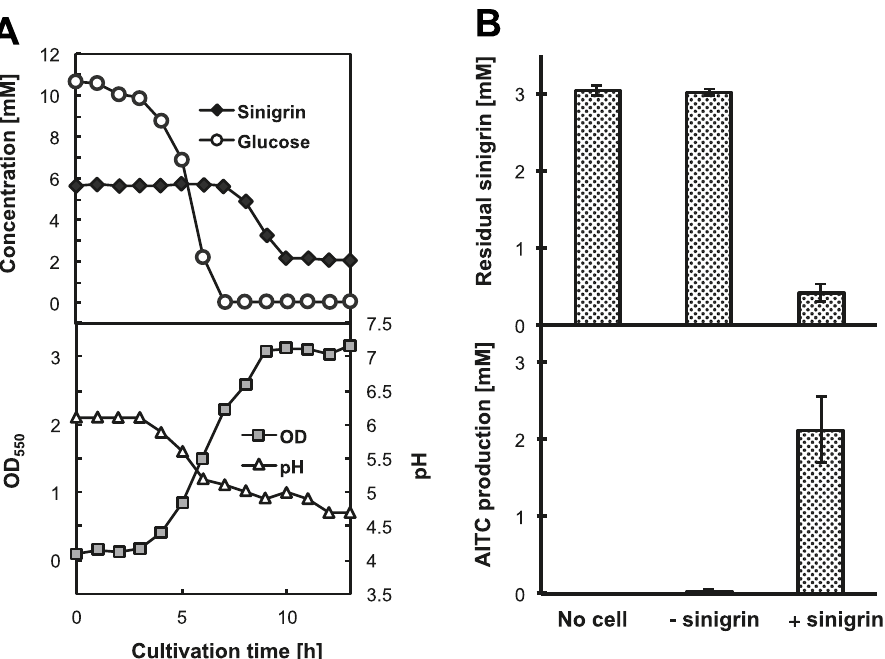
Figure 2. Sinigrin-degrading activity of Cb. farciminis KB1089. ( A ) Profiles of glucose and sinigrin concentrations, optical density (OD 550 ) and pH during Cb. farciminis KB1089 cultivation in the G10S6-mMRS medium. ( B ) Amounts of residual sinigrin (upper graph) and produced AITC (lower graph) in the resting cell reaction mixtures using washed cells obtained after glucose consumption cultivated in G3-mMRS medium (−sinigrin) or G3S3-mMRS medium (+sinigrin). ‘No cell’ indicates a reaction solution without cells. Data represent mean value (n = 3). Error bars indicate 95%